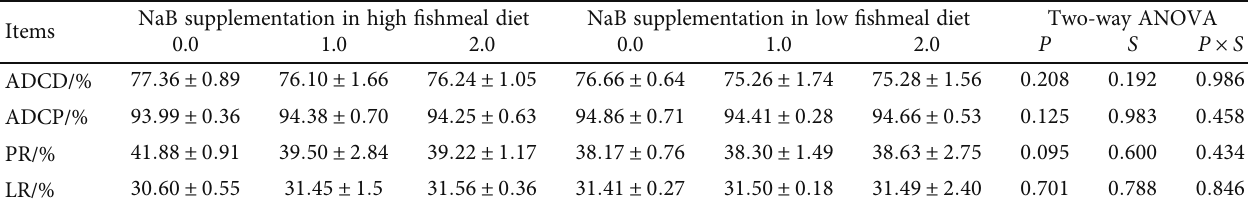
Table 4: E ff ect of dietary sodium butyrate on nutrient utilization of rainbow trout.